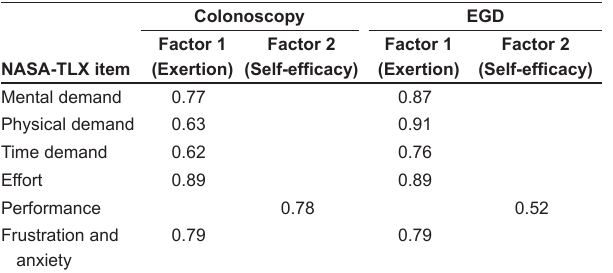
TabLE 1 Principal components of the National aeronautics and Space administration Task Load Index (NaSa-TLX) for colonoscopy and esophagogastroduodenoscopy